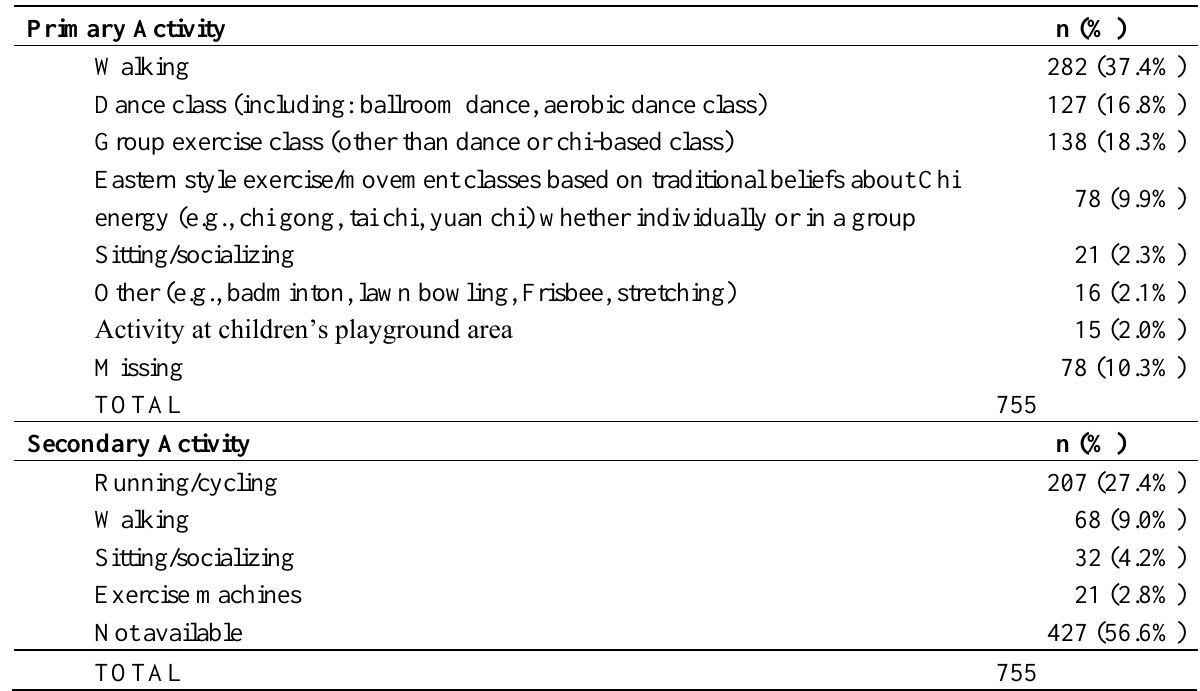
Table 3. Summary of primary and secondary activities of older adults (age 60+). Primary Activity